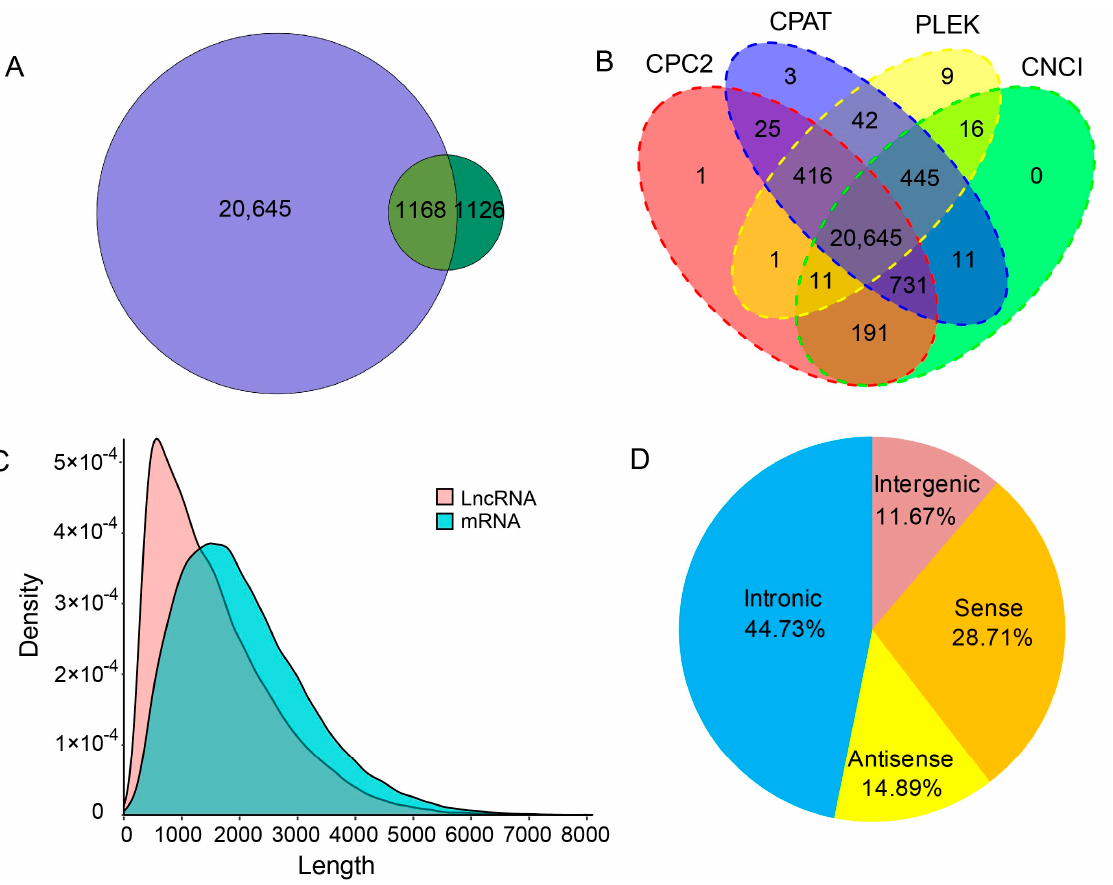
Figure 6. LncRNAs identified from the PacBio honey bee transcriptome. ( A ) Comparison of the lncRNAs identified in this study with those from genome annotation. ( B ) The Venn diagram of the number of lncRNAs predicted by CPC2, CPAT, PLEK and CNCI. ( C ) The length density distribution of lncRNAs and mRNAs. ( D ) Proportions of the four kinds of